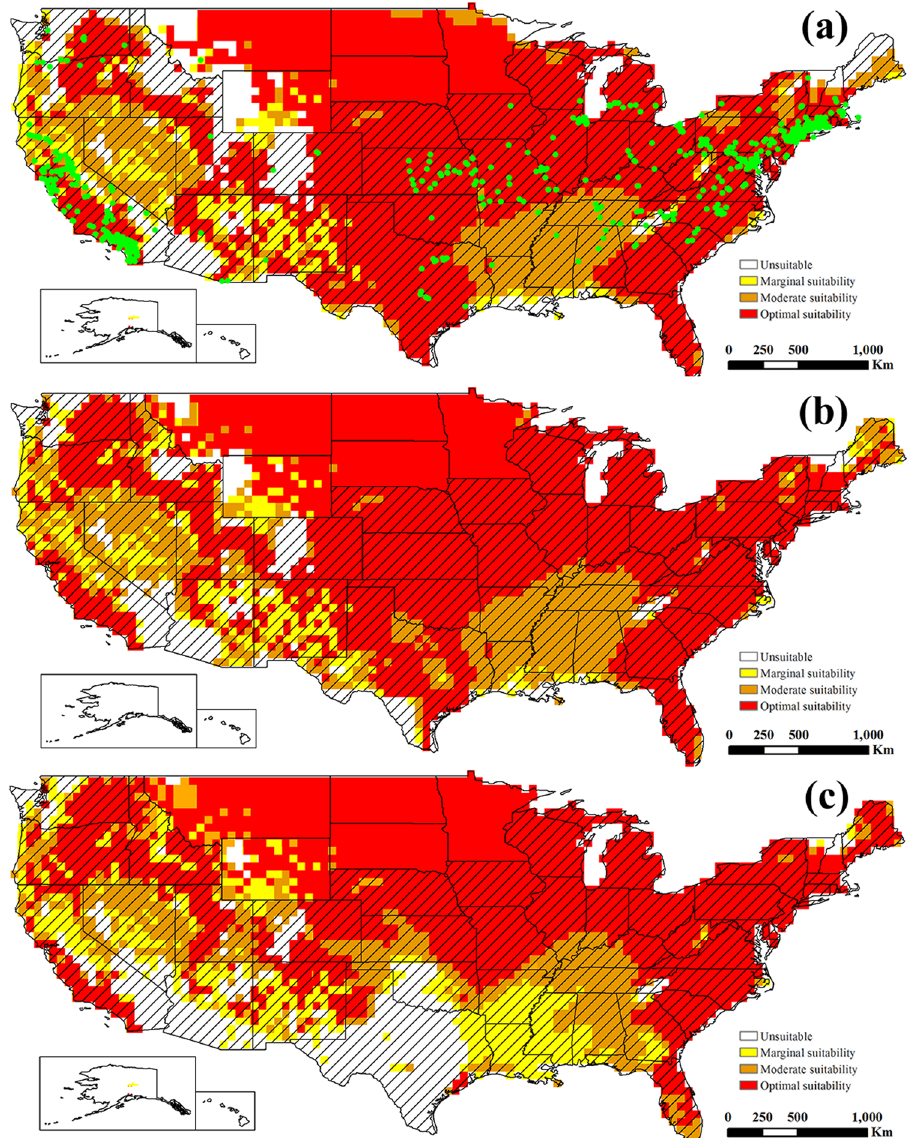
Figure 6. The potential distributions for EBR in the United States, ( a ) under the historical climate, ( b ) under the future climate change scenario RCP 8.5 by the middle of 21st century, ( c ) under the future climate change scenario RCP 8.5 by the end of 21st century. Slash indicate the distribution areas of tree-of-heaven. Green points indicate the distribution locations of tree-of-heaven. White indicates unsuitable areas (EI = 0); Yellow indicates areas of marginal suitability (0 < EI ≤ 10); Orange indicates areas of moderate suitability (10 < EI ≤ 20); Red indicates areas of optimal suitability (EI ≥ 20). The map in this figure was generated by ArcGIS 10.1 (ESRI, Redlands, CA, USA,